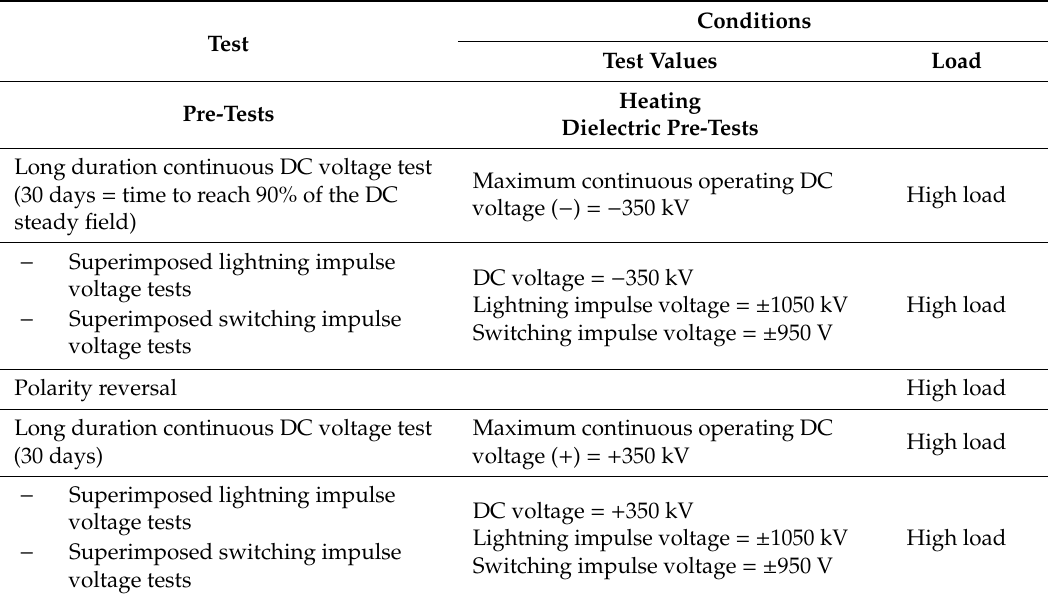
Figure 12. Tests’ verification of the spacers’ insulation performance. ( a ) Test set-up and ( b ) test loop comprising several insulators [11]. Table 2. Sequence of DC insulation system test of the ±320 kV DC GIS [11].